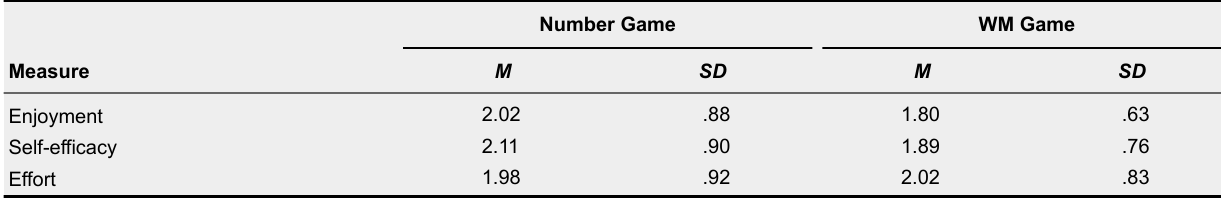
Means and Standard Deviations of the Self-Reported Engagement Measures for the Number and WM Training Games